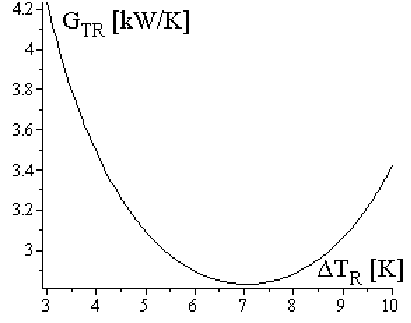
Figure 17. G TR dependence of ∆ T R —case “b”. G TRmin = 2.832 for ∆ T R = 7.06 K.